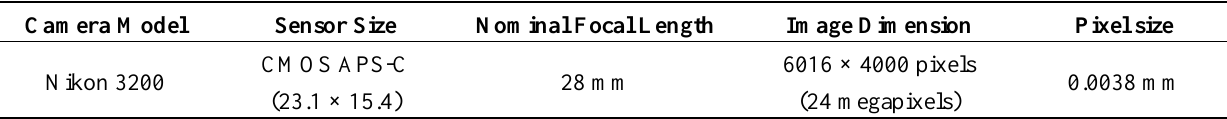
Table 5 . Technical specifications for the camera